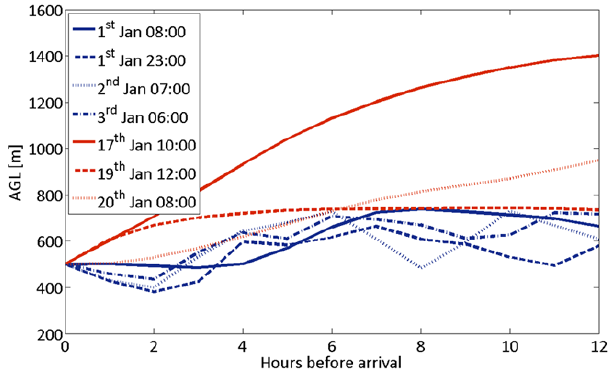
Fig. 11. Trajectory height above ground during event periods 1 to 3 and 17 to 20 January Figure 11 Trajectory height above ground during event periods 1st to 3rd and 17th to 20th 3